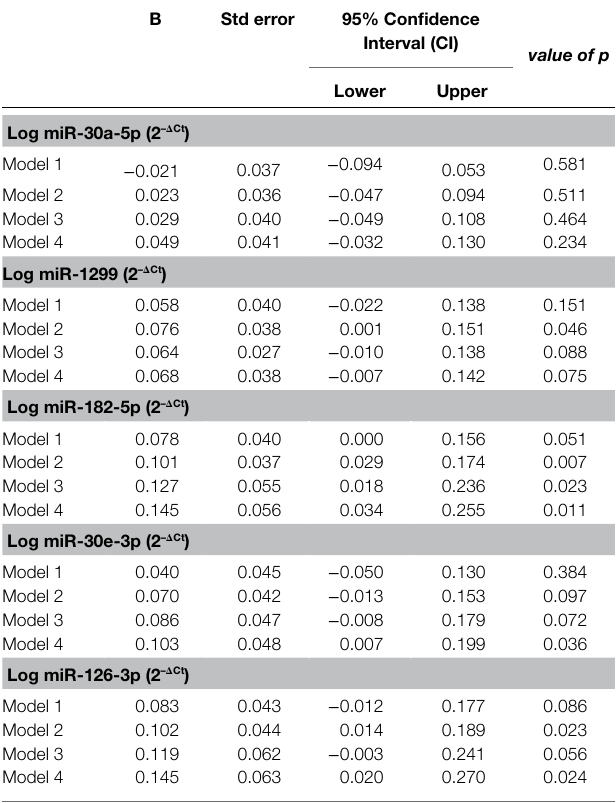
TABLE 4 | Univariate regression analysis of miRNAs for the duration of